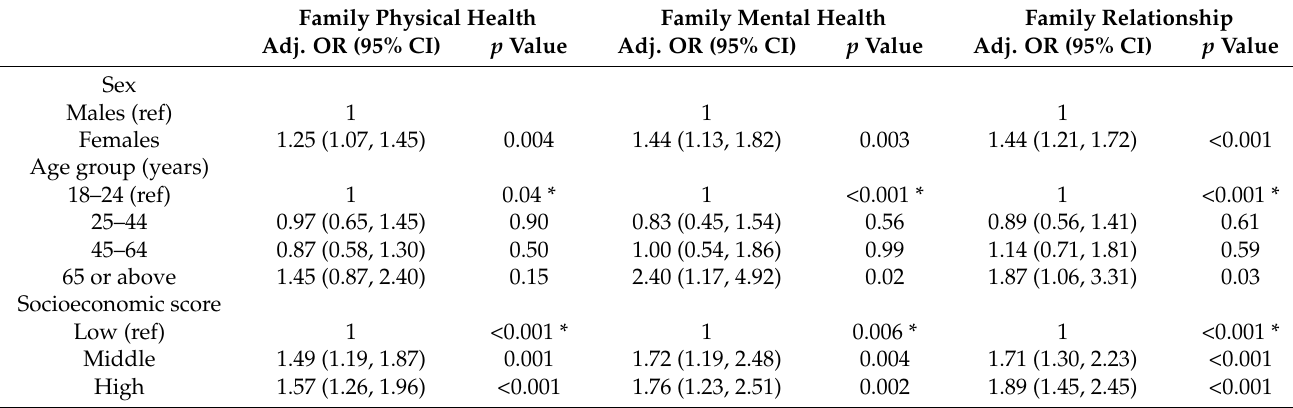
Table 4. Association of perceived benefits of COVID-19 on family well-being with demographic and socioeconomic